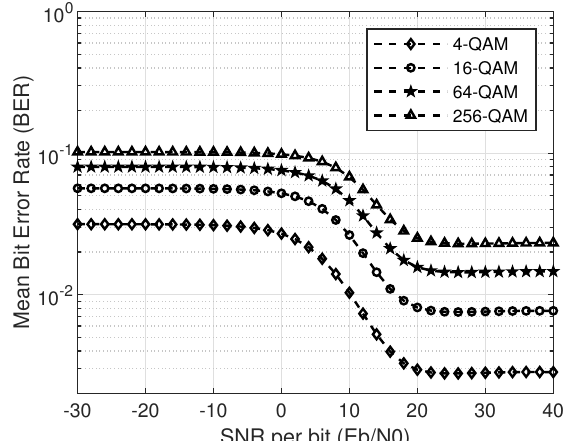
Figure 8. Mean BER of M-QAM with M = 4,16,64 and 256 and q = 17